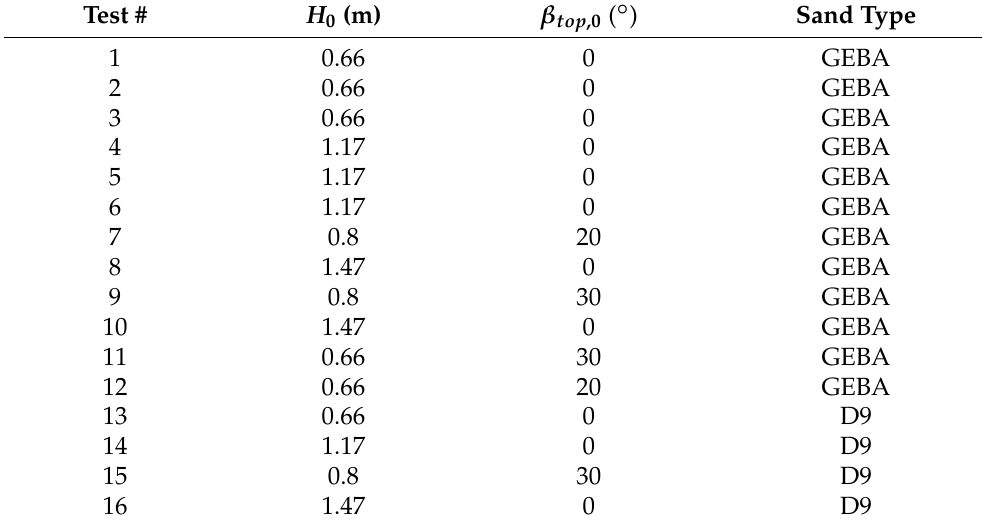
Table 2. A summary of the experiments conducted within this study. H 0 is the breach height and β top ,0 is the angle of the slope at the top of the breach face, both at the start of the experiment (see Figure 5).